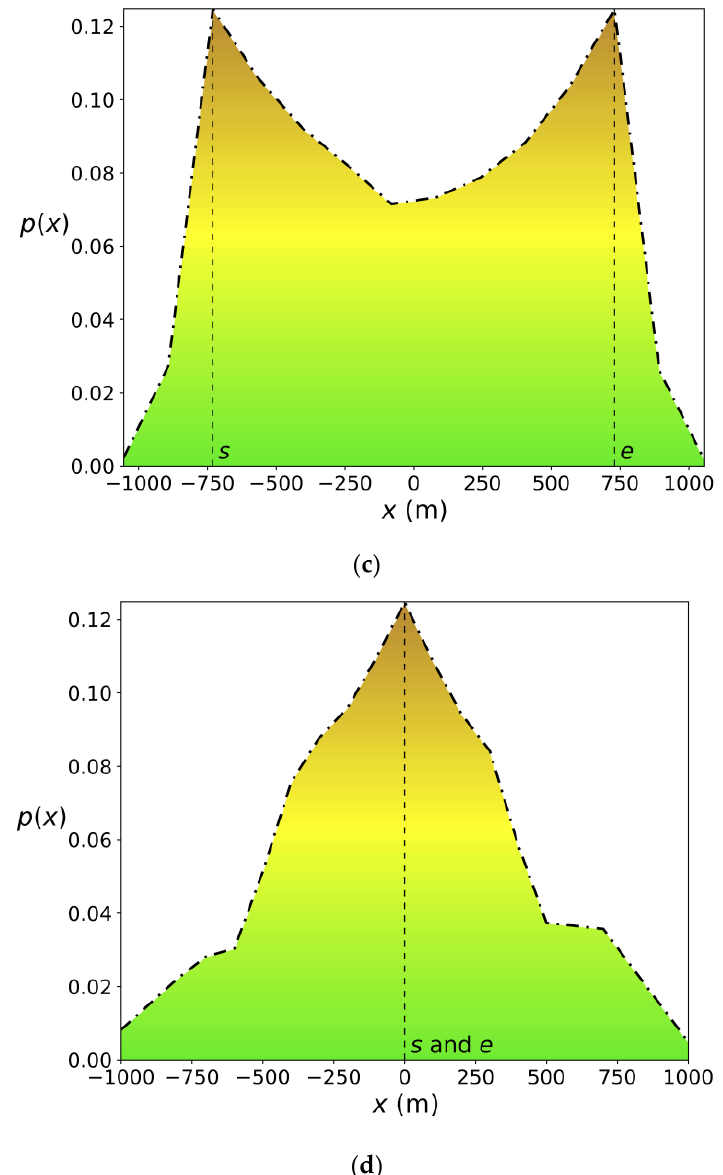
Figure 9. Kernel function on PNA: ( a ) discrete type; ( b ) continuous type; ( c ) front view; ( d ) side view.